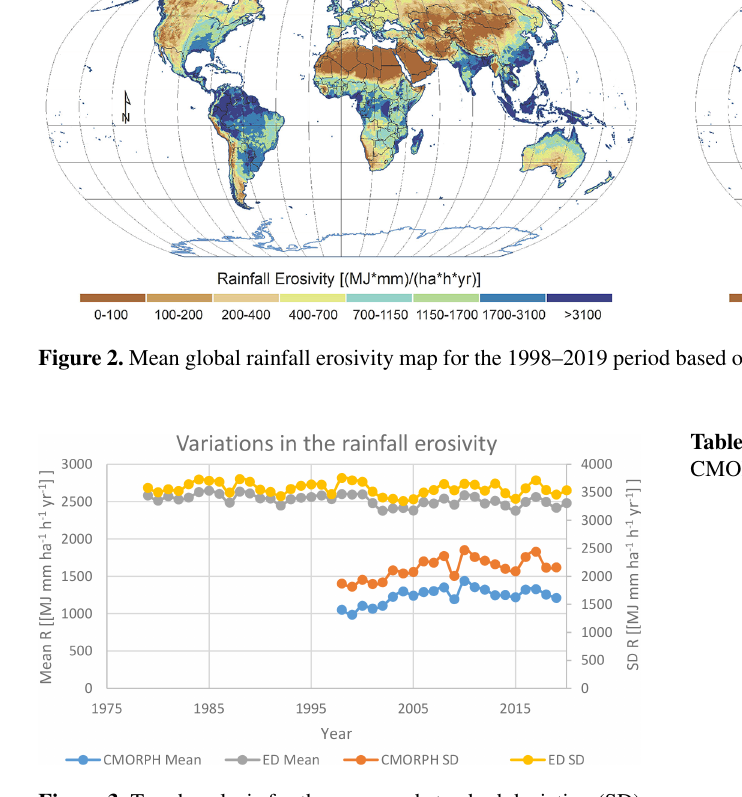
Figure 3. Trend analysis for the mean and standard deviation (SD) for annual rainfall erosivity ( R ) using CMORPH and ED.